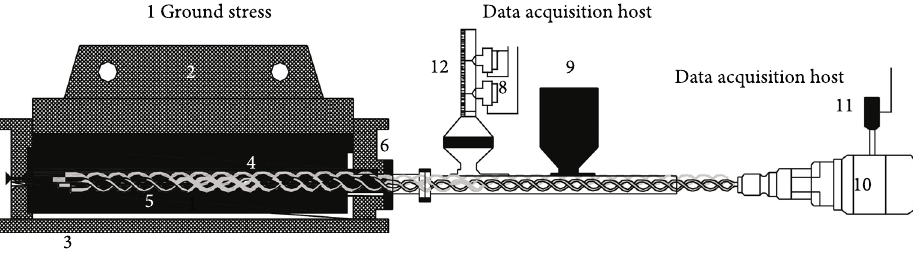
Figure 2: Experimental device. 1 — press machine; 2 — pressure pole; 3 — cylindrical block; 4 — drill pipe; 5 — coal seam; 6 — stopper; 7 — large fl ow sensor; 8 — small fl ow sensor; 9 — coal bunker; 10 — electric coal drill; 11 — displacement sensor; 12 — fl ow